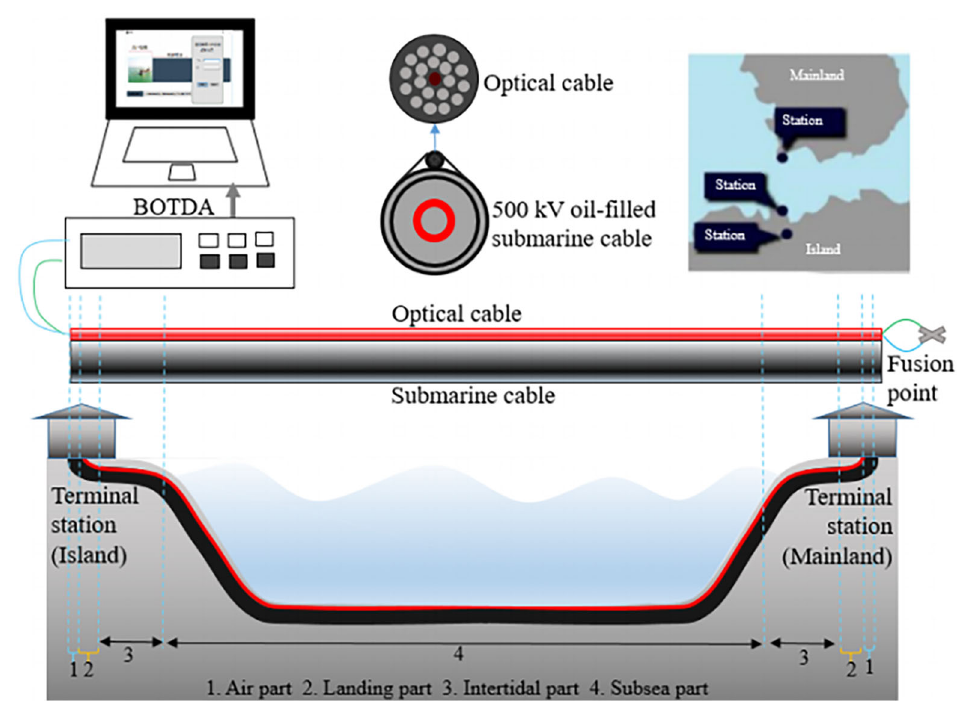
Figure 12. Submarine cable temperature monitoring in China’s southern coast using BOTDA sens ‐ ing system. Reprinted with permission from [172].